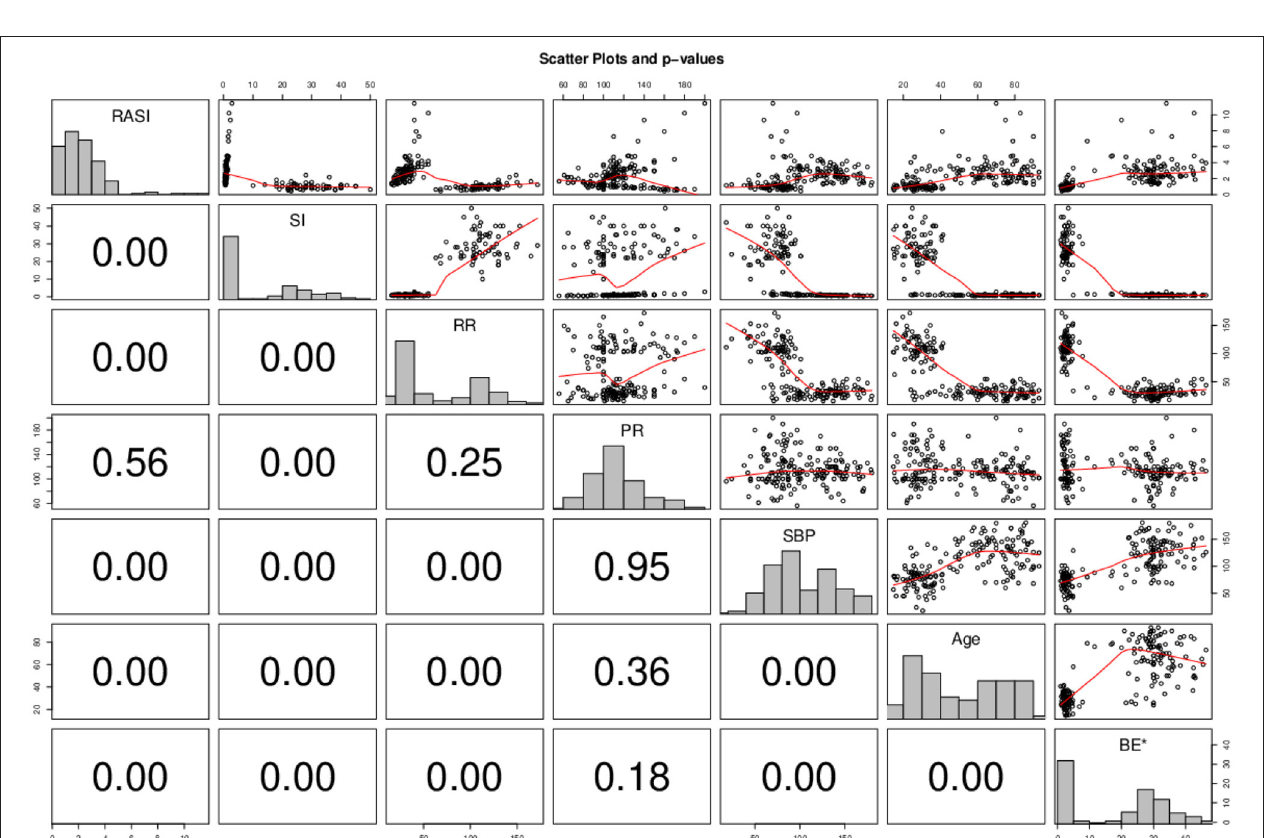
FIGURE 2 | Correlation matrix of study variables. P- value is shown numerically on the left side of the matrix. * To display BE numerical values in the graph due to the negative number of data, all values are added with a fixed value. X border and corresponding border in front is belonging to the first variable in each histogram and the Y and the border in front is belonging to the second variable of the correlation test.